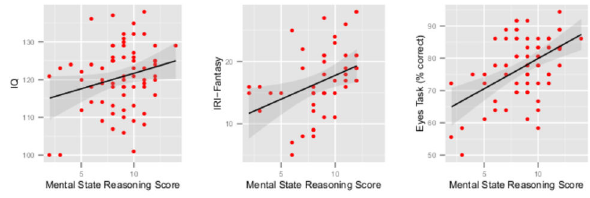
Figure 3. Relationship between mental state reasoning scores and IQ, fantasy, and eyes task scores. Shaded area represents 95%